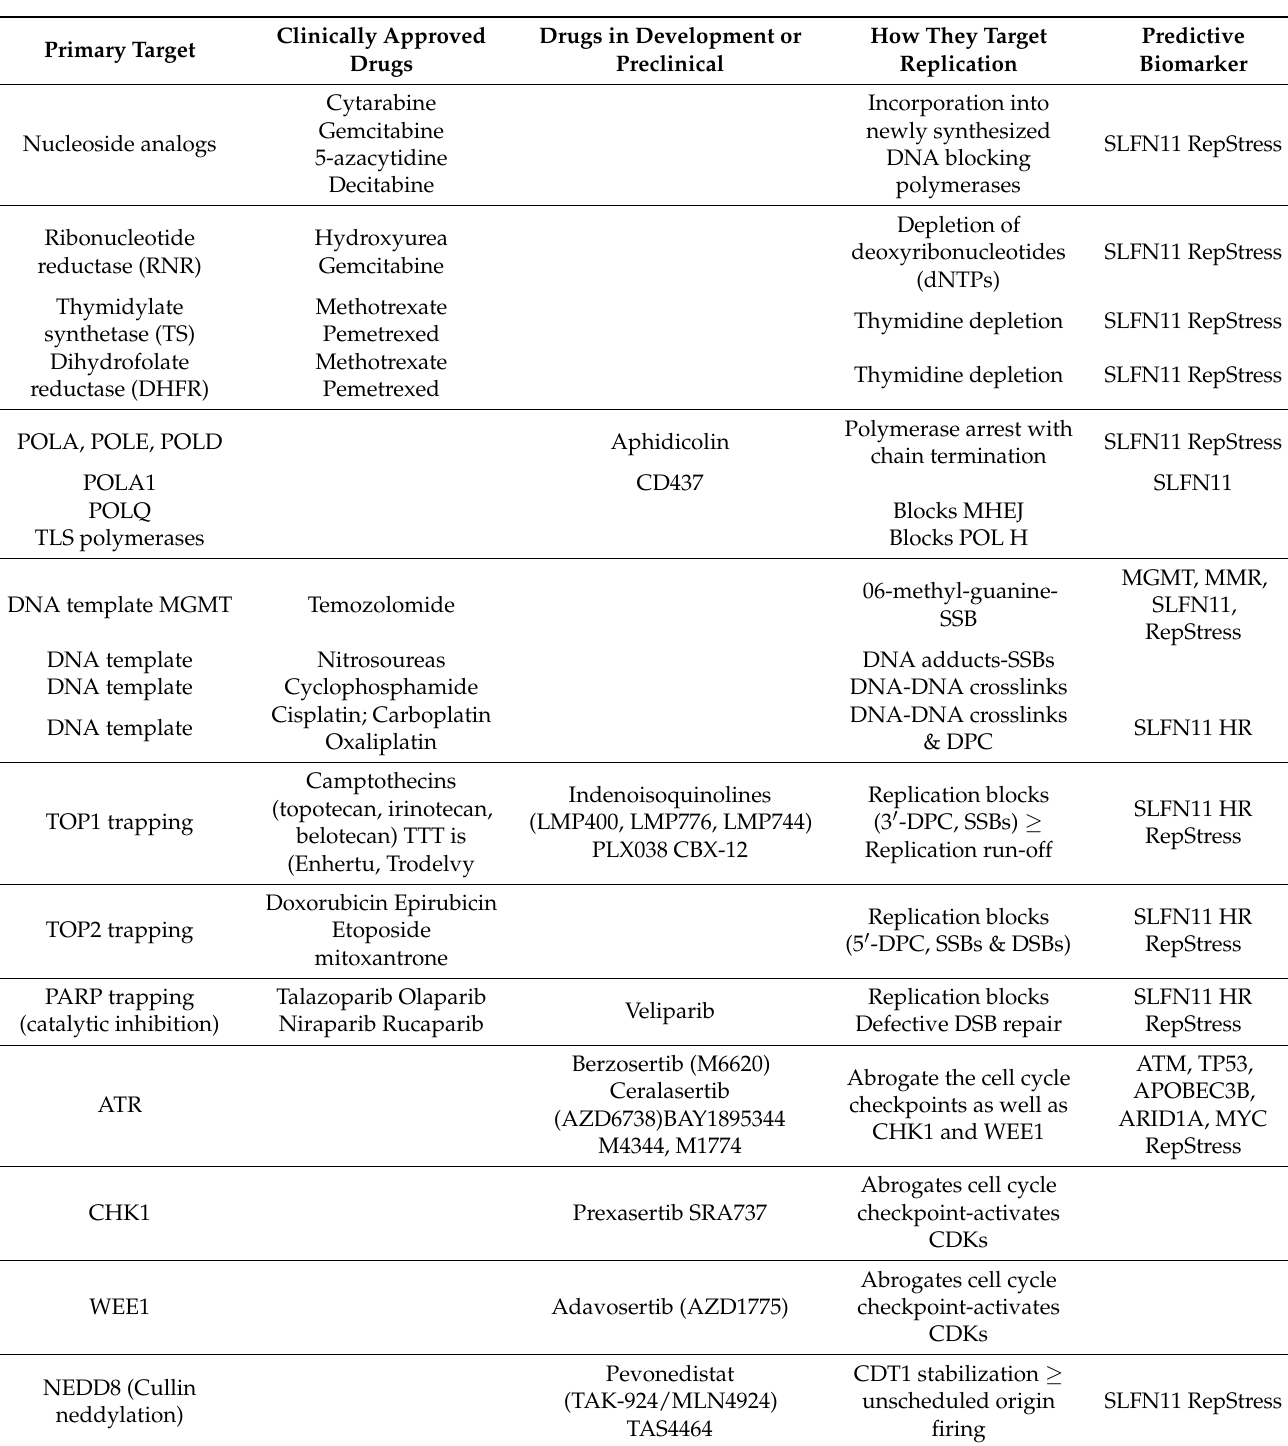
Table 1. Pharmacological targets and drugs inducing replication